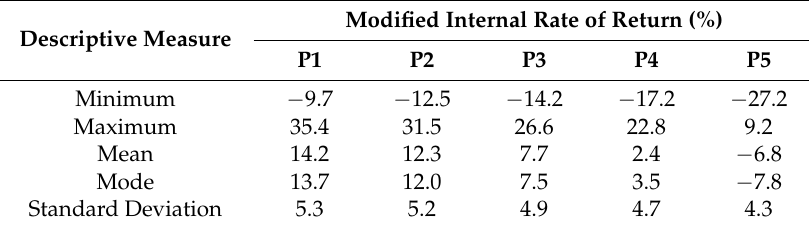
Table 3. Descriptive measures of the modified internal rate of return ( MIRR ) of the investment projects in forest stands used for the biomass production of the main bole of eucalyptus.